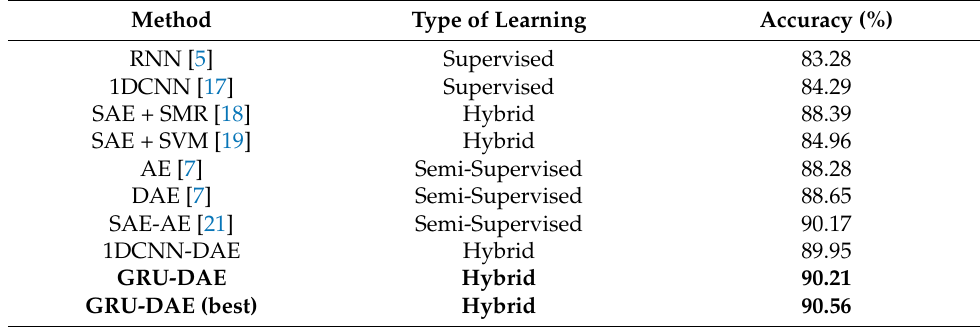
Table 9. Comparison between GRU-DAE model and other approaches.